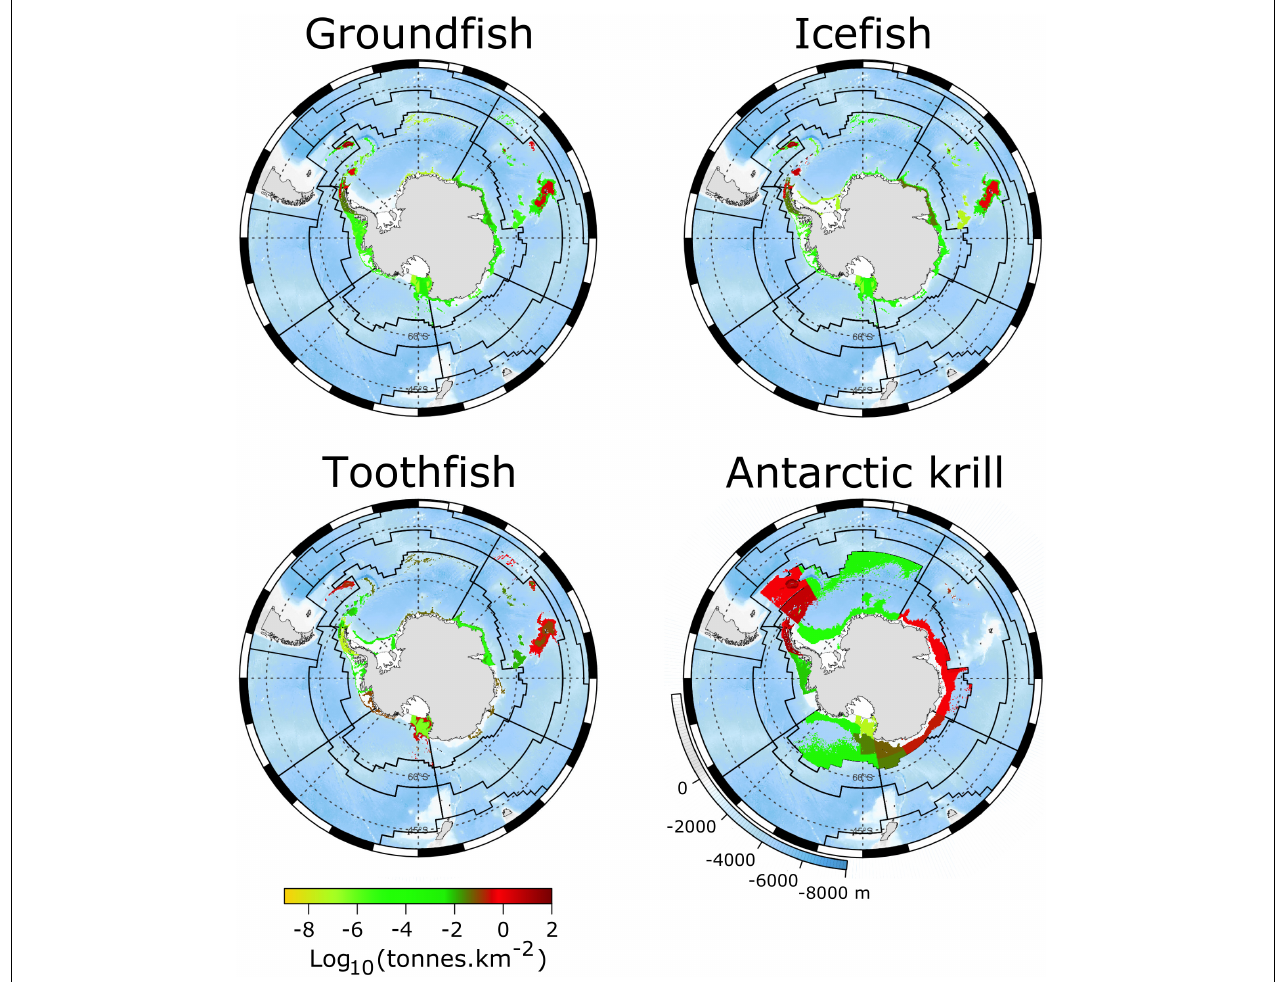
FIGURE 9 | Accumulated catch for groundfish, icefish, toothfish and Antarctic krill from 1970 to 2018 plotted against ocean depth (legend at bottom left of Antarctic krill panel) as catch density (tonnes per square kilometre) on a log 10 scale (bottom left legend). Species are those listed in Figure 8 . Source data: CCAMLR Statistical Bulletin 2019. Grey lines show a graticule, and black lines show the boundaries of the 15 MEASO areas in Figure 2